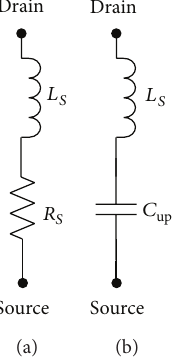
Figure 10: Equivalent circuit of a RF-MEMS switch in two-bias conditions; (a) the ON - state and (b) the OFF - state